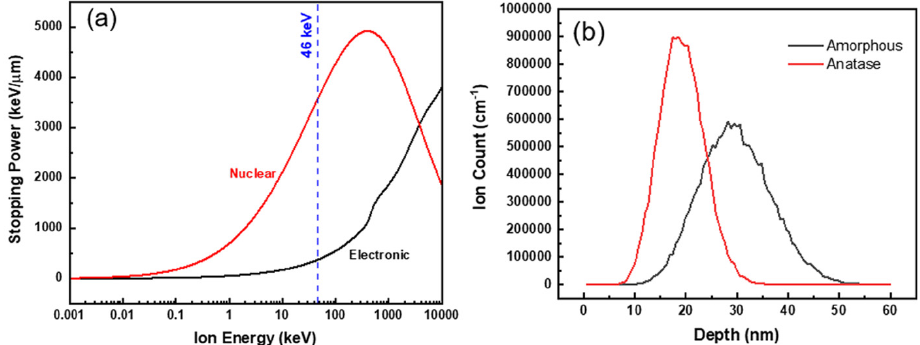
Figure 8. ( a ) Nuclear and electronic stopping power profiles and ( b ) ion range profiles for amor- phous TiO 2 nanotubes. Reproduced with permission from ref.